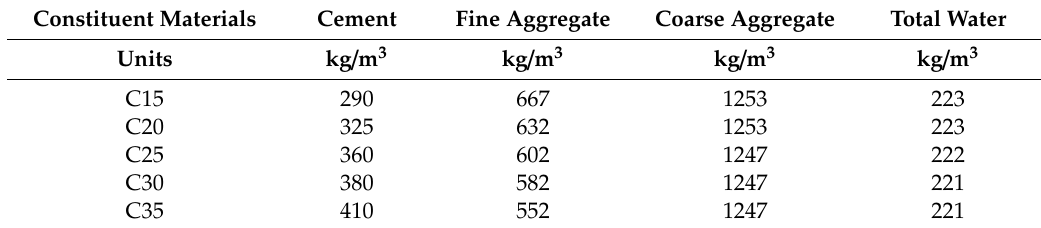
Table 2. Concrete mix-design.